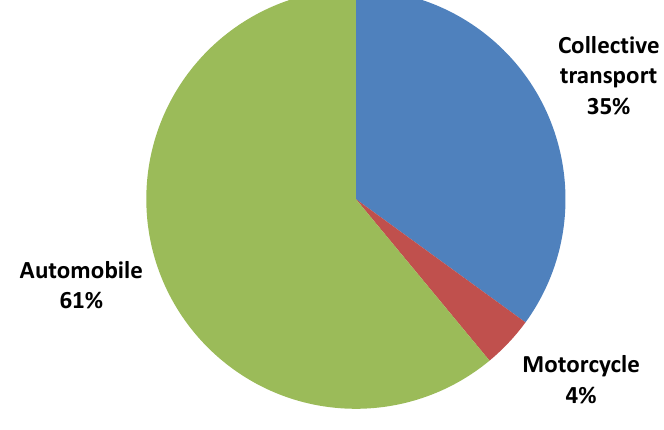
Figure 4. Total emissions of atmospheric pollutants in 2008. Source: MMA